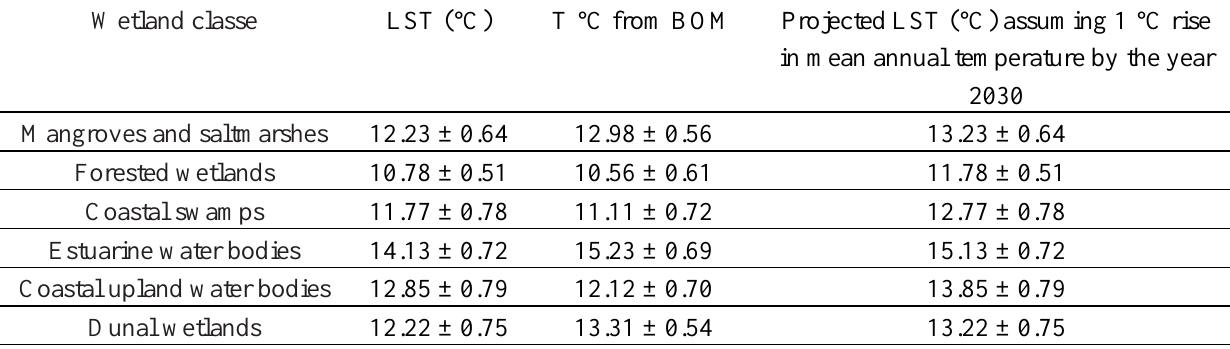
Table 3. Estimated mean LST and projected LST for the wetland classes in the winter month of June including standard error of the mean